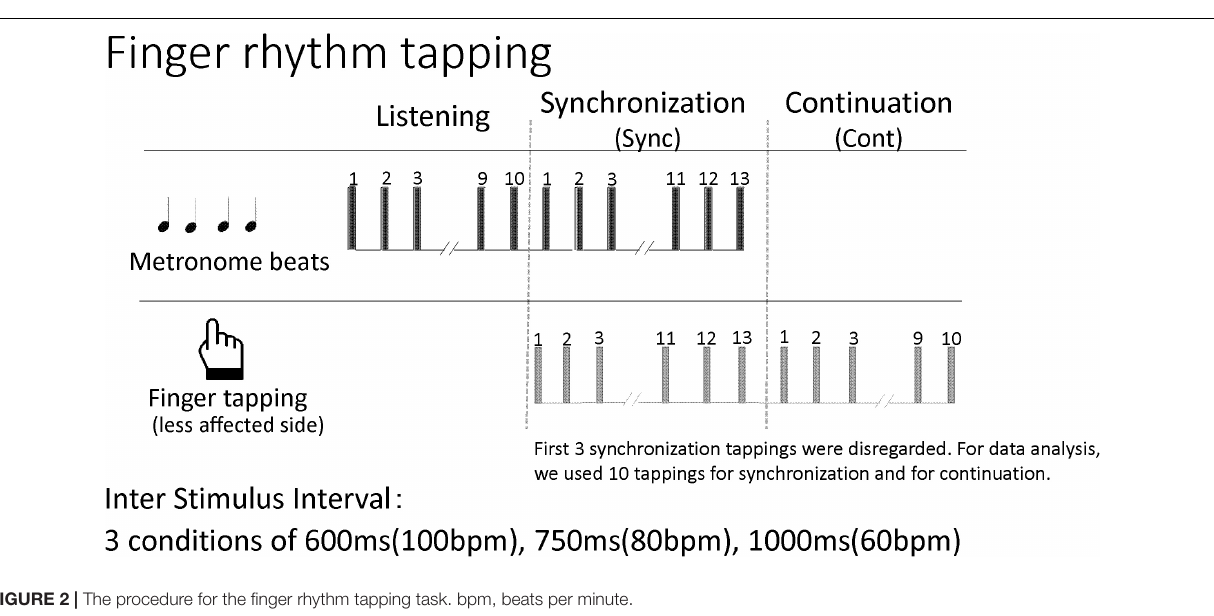
FIGURE 2 | The procedure for the finger rhythm tapping task. bpm, beats per minute.